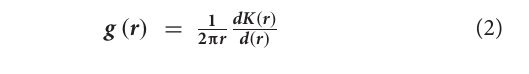
the g( r ) function to analyze the spatial distribution patterns of Assuming that the complete spatial randomness (CSR) null model condition holds, g( r ) = 1, indicate random distribution each tree (Wiegand and Moloney, 2013): pattern, g( r ) < 1 indicate regular distribution pattern, while values of g( r ) > 1 indicate aggregated spatial distribution dK ( r ) g ( r ) = 1 (2) d ( r ) 2 π r